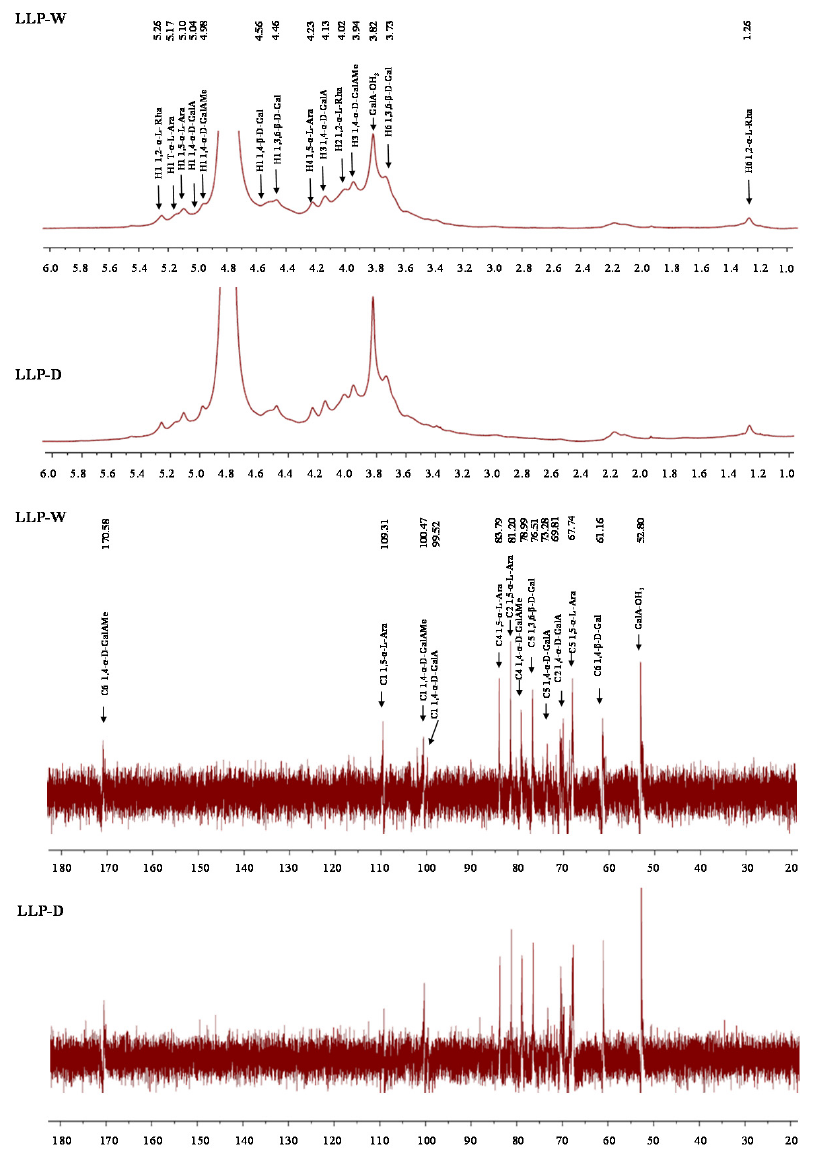
Figure 5. 1 H and 13 C NMR spectra of LLP-D and LLP-W. LLP-D and LLP-W are polysaccharides from lotus leaves extracted by deep eutectic solvent and hot water,